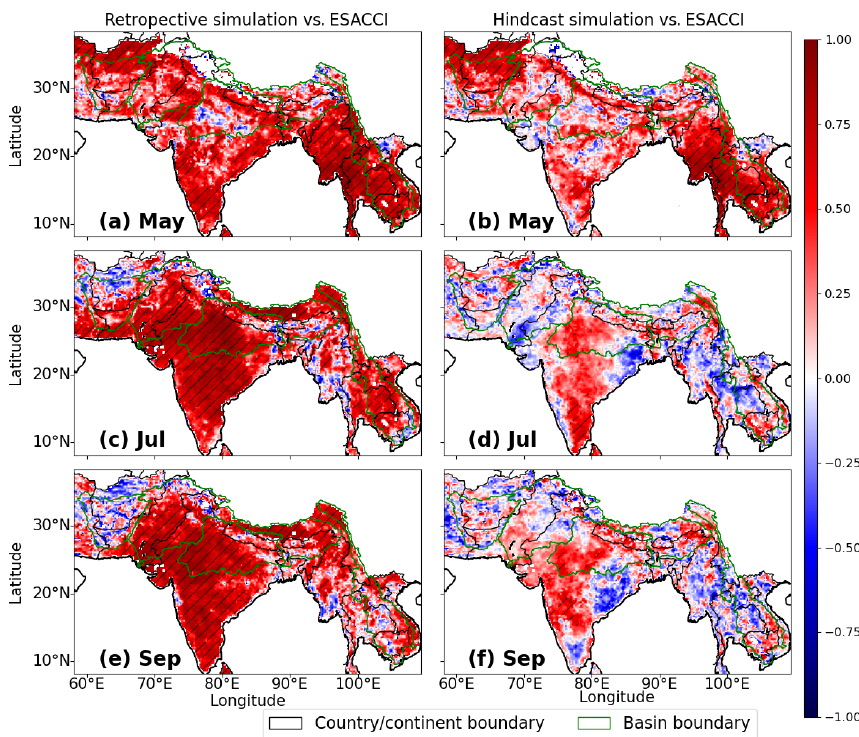
Figure 9. Surface soil moisture (top 10cm) correlation between European Space Agency Climate Change Initiative (ESA CCI) soil moisture product and (a, c, e) retrospective simulations, and (b, d, f) forecasting simulations in May, July, and September. The hatched areas denote the statistically significant correlation at 0.95 confidence